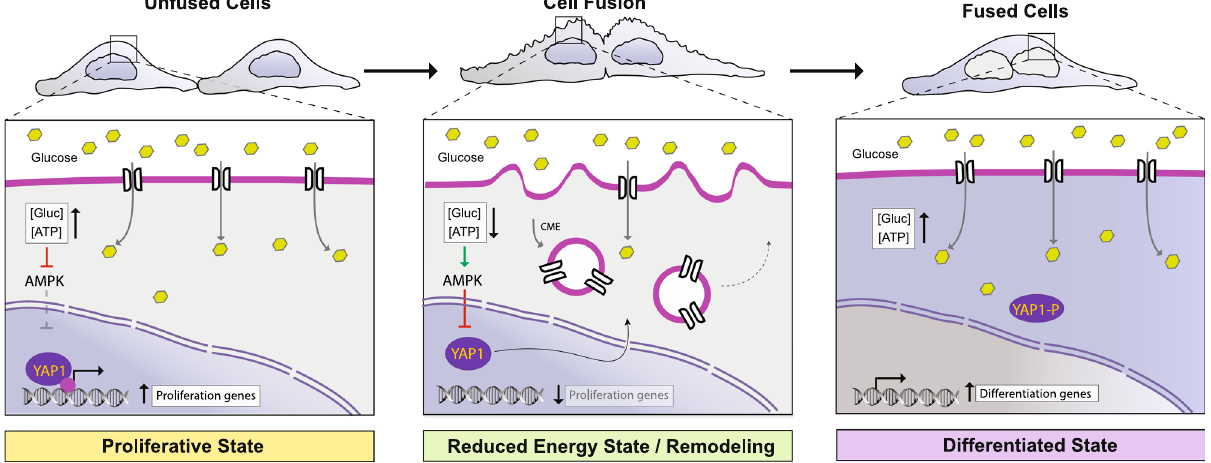
Fig. 8 Structural remodeling upon cell fusion leads to endocytosis and AMPK-dependent YAP1 inhibition, which drives cell-cycle arrest and promotes a differentiated-like state. In proliferating cells, nuclear YAP1 promotes expression of genes to support the proliferative state. The acute structural remodeling upon cell fusion, including endocytosis of glucose transporters, causes transient changes in cell energetics (decreased cytoplasmic glucose and ATP) and AMPK activation that lead to persistent retention of YAP1 in the cytoplasm. As a result, fused cells exit the cell cycle and transcripts that promote cell differentiation are